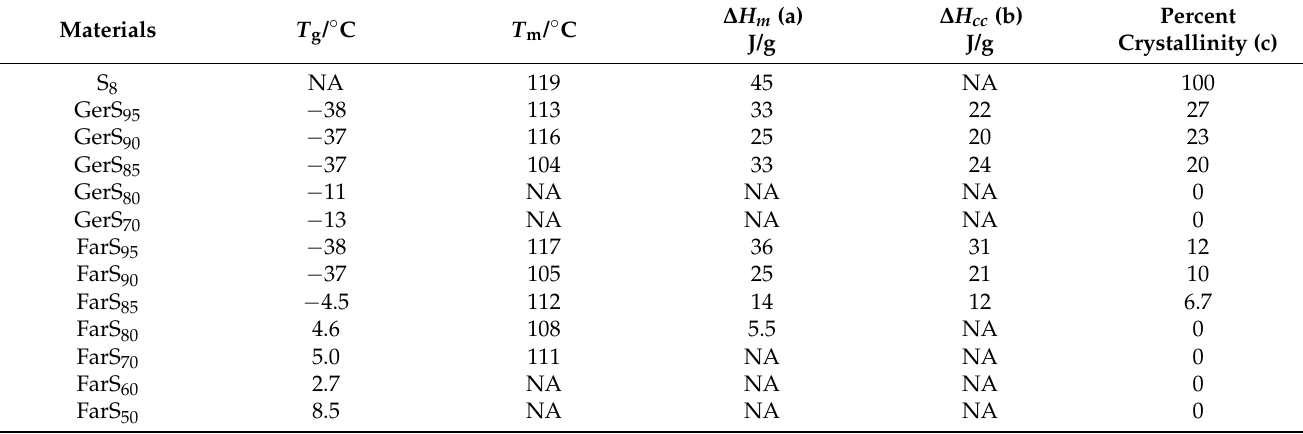
Table 1. Thermal properties of terpenoid-sulfur composites and comparison to elemental sulfur (orthorhombic). Materials T g / ◦